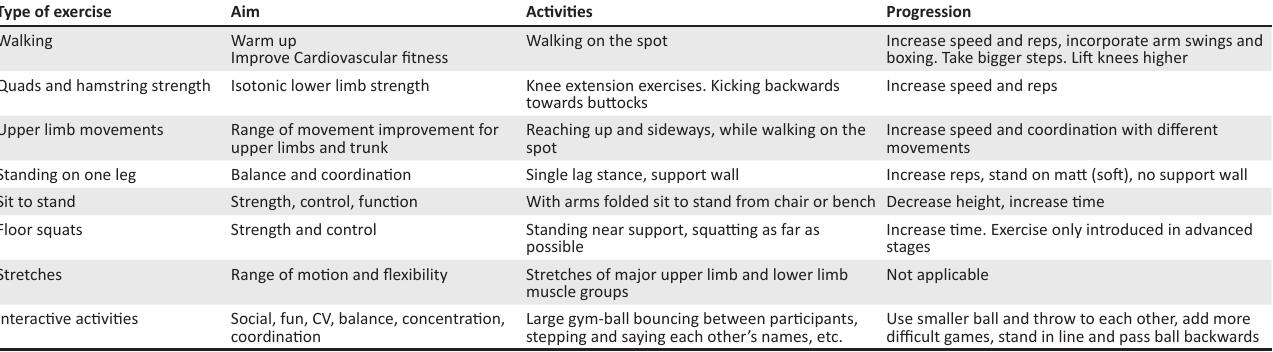
TABLE 2: Exercises included in the intervention. Type of